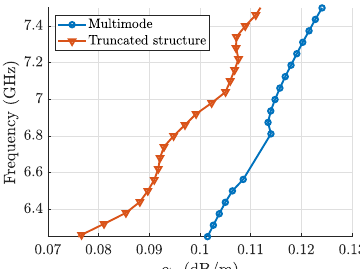
Figure 9. Attenuation constant using both the multimode analysis and the simulation of a truncated structure. The parameters are: p = 15.4mm, w = p /4, r 1 = 7mm, r 2 = 4.2mm, (cid:101) 1 = 10 and (cid:101) 2 = 3. Both materials are simulated with tan δ =